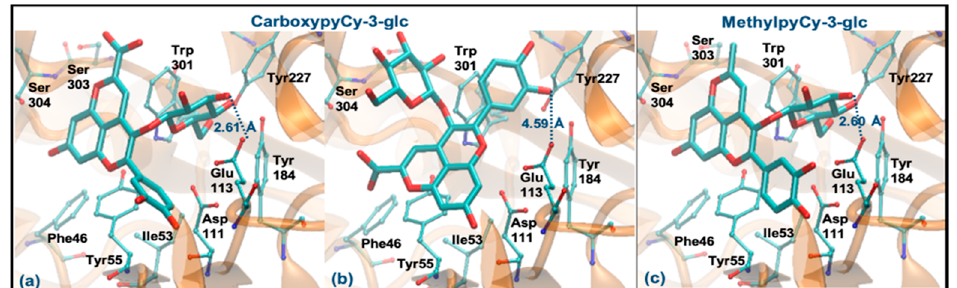
Figure 8. Representation of the structure of hyaluronidase complexed with CarboxypyCy-3-glc (interaction by glucose—( a ), interaction by ring B—( b )) and MethylpyCy-3-glc ((interaction by glucose—( c )), showing the interacting residues of the active site. The enzyme is depicted in cartoon and colored in orange, the ligands are represented with sticks and colored by atom type, whilst the interacting residues are depicted in ball-and-sticks and colored by atom type. Hydrogen atoms are not represented to simplify the visualization.